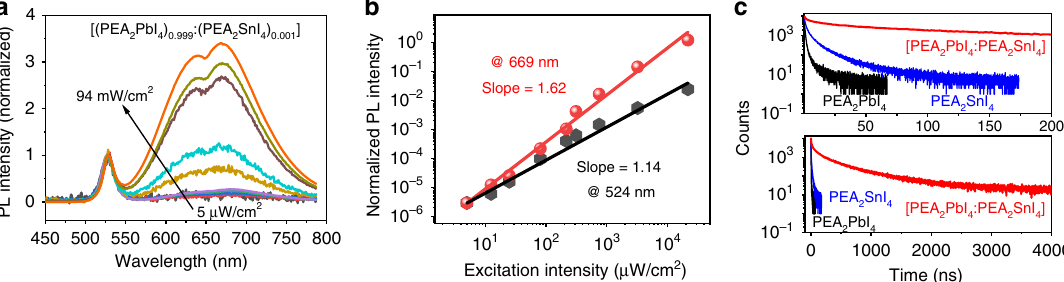
Fig. 2 PL characteristics for 2D perovskite heterostructured [(PEA 2 PbI 4 ) 0.999 :(PEA 2 SnI 4 ) 0.001 ] fi lm. a Normalized PL spectra at different excitation intensities ranging from 5 to 94 mW/cm 2 . b PL-excitation intensity dependences for broad emission (peaked at 669 nm) as compared to intrinsic emission (524 nm) from host (PEA 2 PbI 4 ). c PL lifetime results for broad emission (peaked at 669 nm) in 2D perovskite heterostructures and intrinsic emission (peaked at 524 nm, and 621 nm) from host (PEA 2 PbI 4 ) and guest (PEA 2 SnI 4